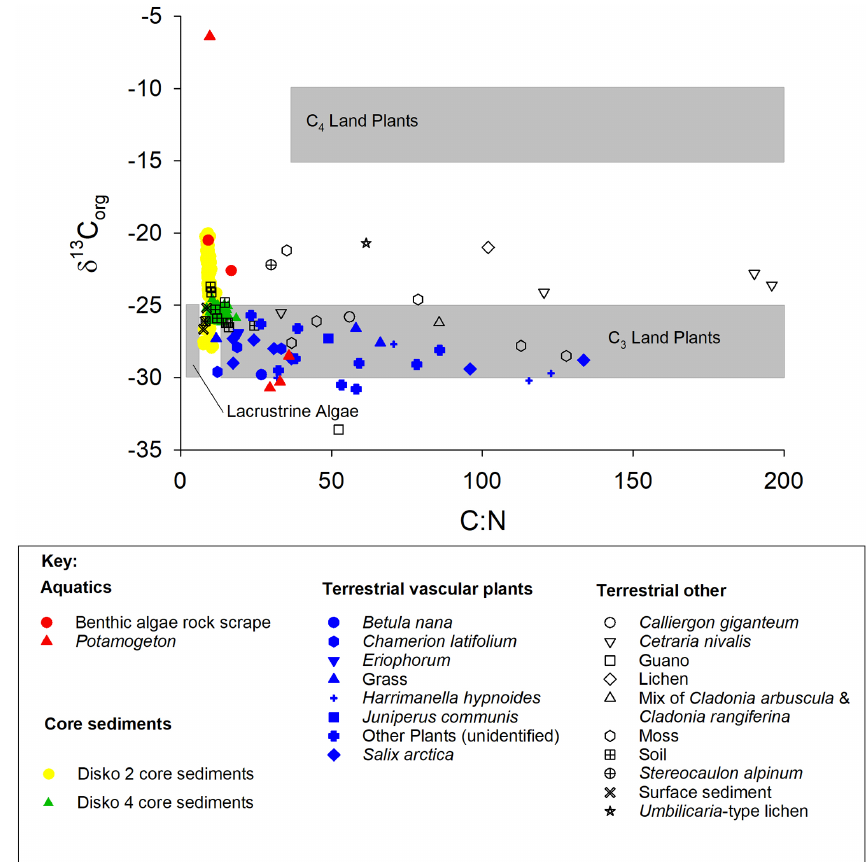
Figure 4. C org / N vs. δ 13 C org for catchment end-member samples and sediments from all three Disko catchment study areas. Grey shaded regions show expected zones for C 4 land plants, C 3 land plants and lacustrine algae according to Meyers